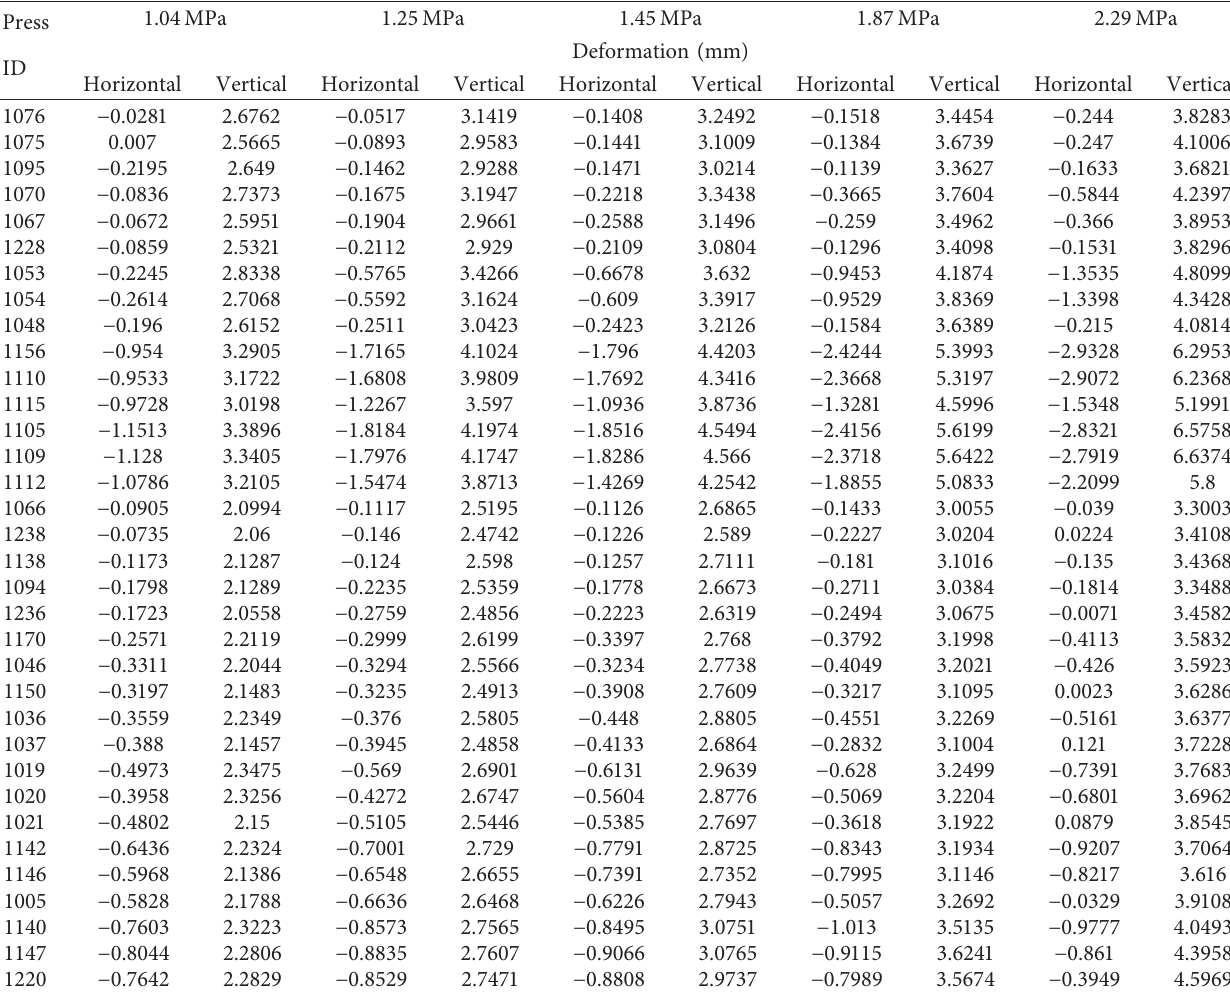
Table 3: Deformation of some noncoding point